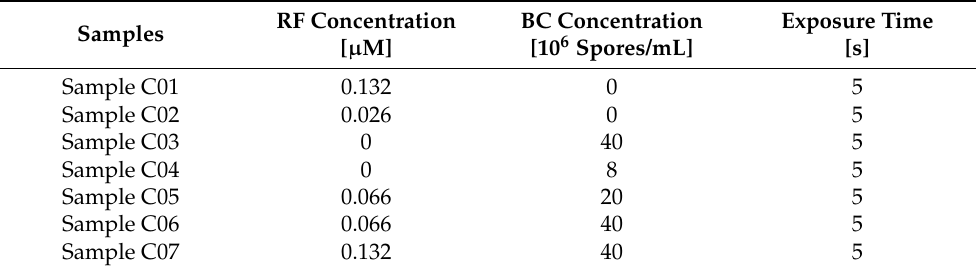
Table 1. Sample composition used for experimental tests and exposure time used for each acquisition.